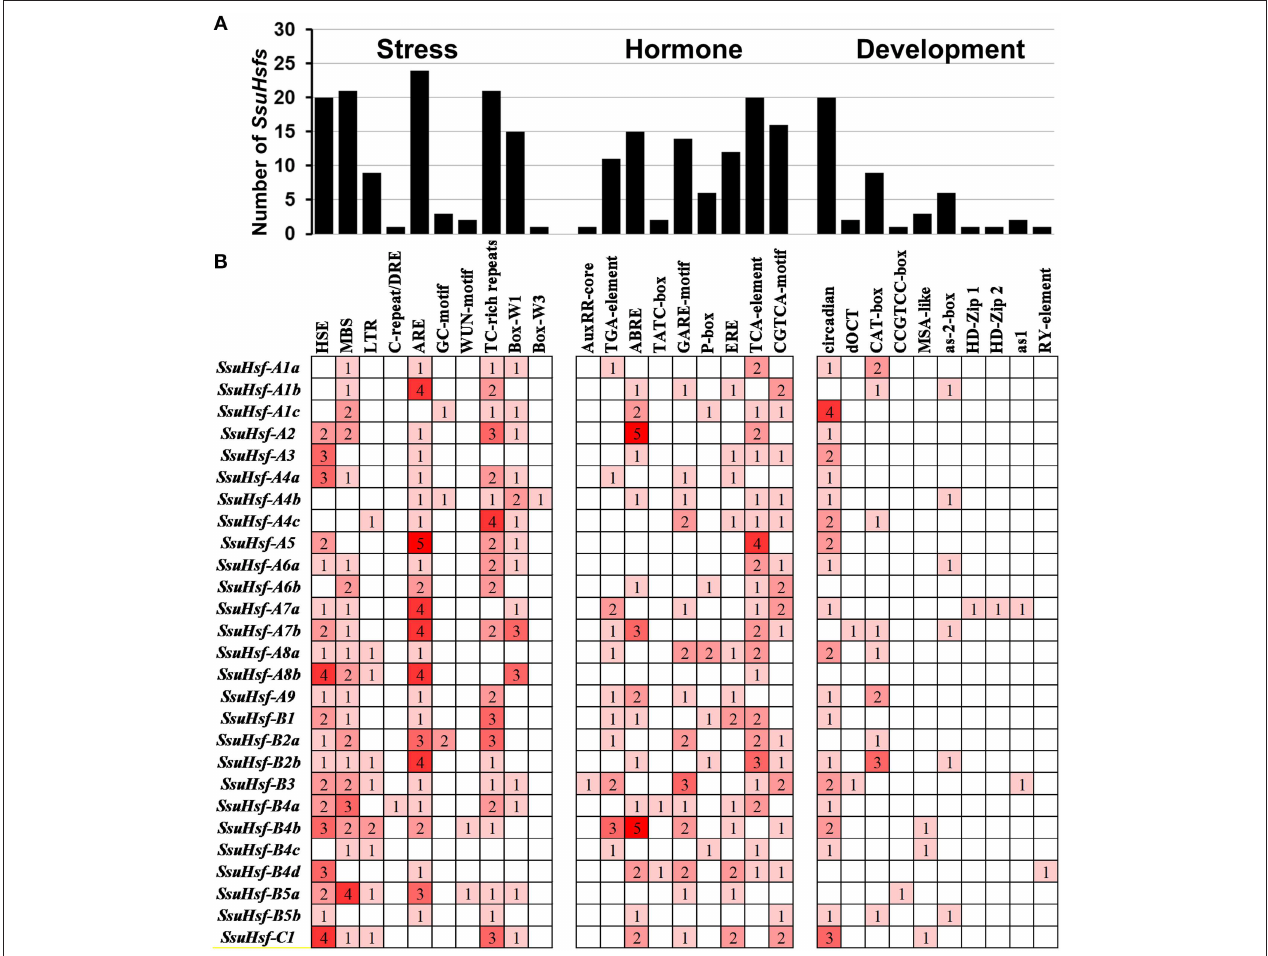
FIGURE 6 | Various cis -acting elements in SsuHsf genes. (A) The number of SsuHsf genes containing various cis -acting elements. (B) The number of occurrences of each cis -acting elements in the promoter region of each of SsuHsf genes. The annotation of the cis -elements: HSE, cis -acting element involved in heat stress responsiveness; MBS, MYB binding site involved in drought-inducibility; LTR, involved in low-temperature responsiveness; C-repeat/DRE, involved in cold- and dehydration-responsiveness; ARE, essential for the anaerobic induction; GC-motif, enhancer-like element involved in anoxic specific inducibility; WUN-motif, wound-responsive element; TC-rich repeats, involved in defense and stress responsiveness; Box-W1 and Box-W3, fungal elicitor responsive element; AuxRR-core and TGA-element, auxin-responsive element; ABRE, involved in the abscisic acid responsiveness; TATC-box, GARE-motif and P-box, gibberellin-responsive element; ERE, ethylene-responsive element; TCA-element, involved in salicylic acid responsiveness; CGTCA-motif, involved in the MeJA-responsiveness; circadian, involved in circadian control; dOCT and CAT-box, related to meristem expression; CCGTCC-box, related to meristem specific activation; MSA-like, involved in cell cycle regulation; as-2-box, involved in shoot-specific expression and light responsiveness; HD-Zip1, involved in differentiation of the palisade mesophyll cells; HD-Zip2, involved in the control of leaf morphology development; as1, involved in the root-specific expression; RY-element, involved in seed-specific